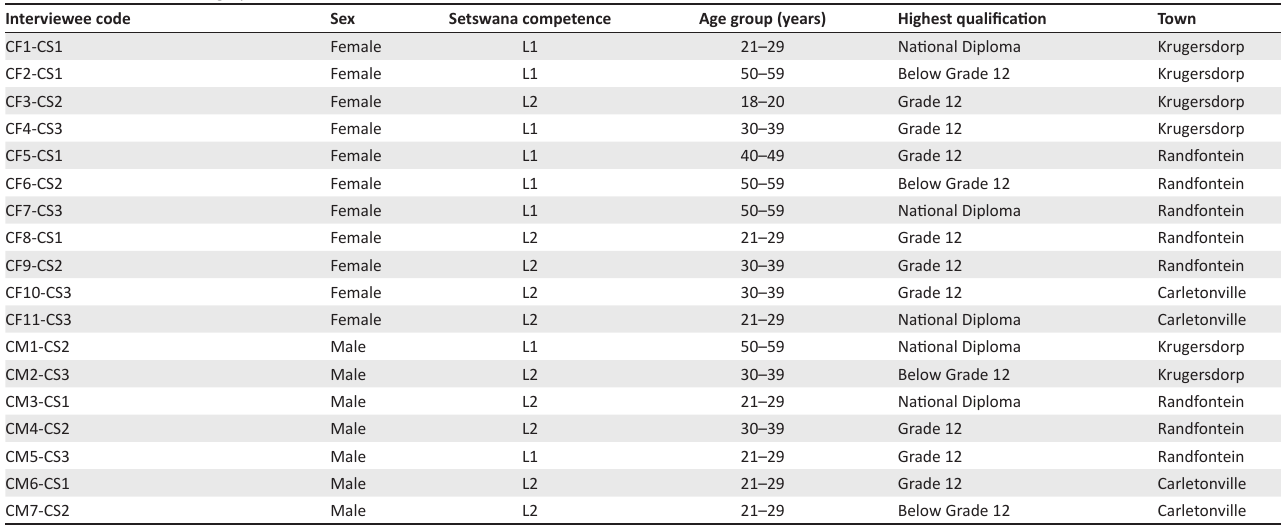
TABLE 1-A1: Customers’ biographic details.